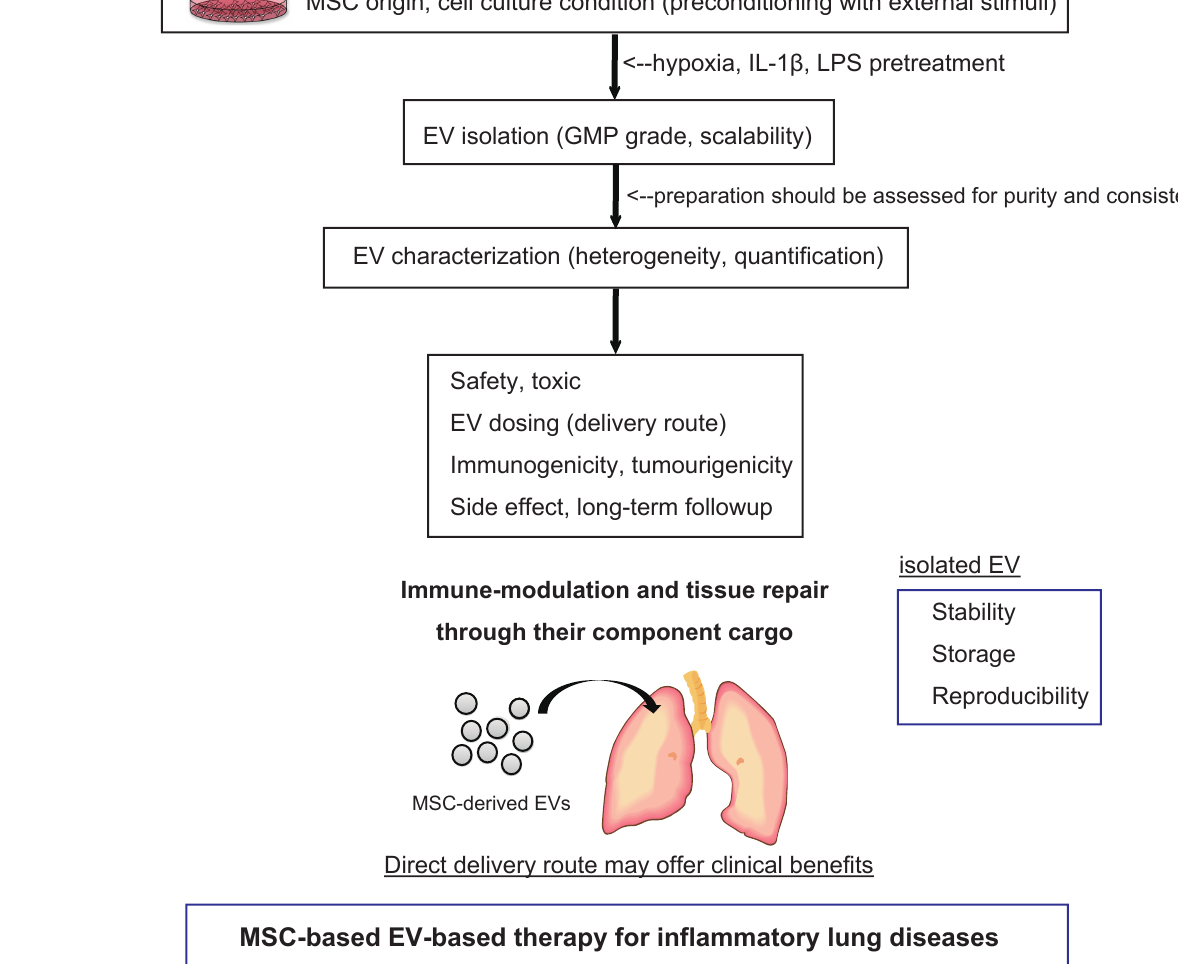
Figure 2. Schematic representation of the proposed therapeutic strategy of MSC-derived EVs in inflammatory lung